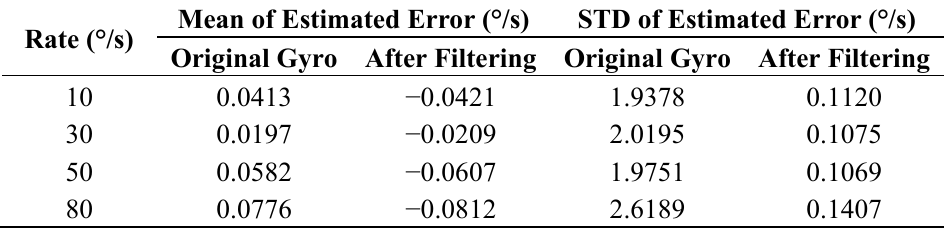
Figure 7. Test results of KF with different constant input rates. Table 3. Test results of constant input rate before and after KF